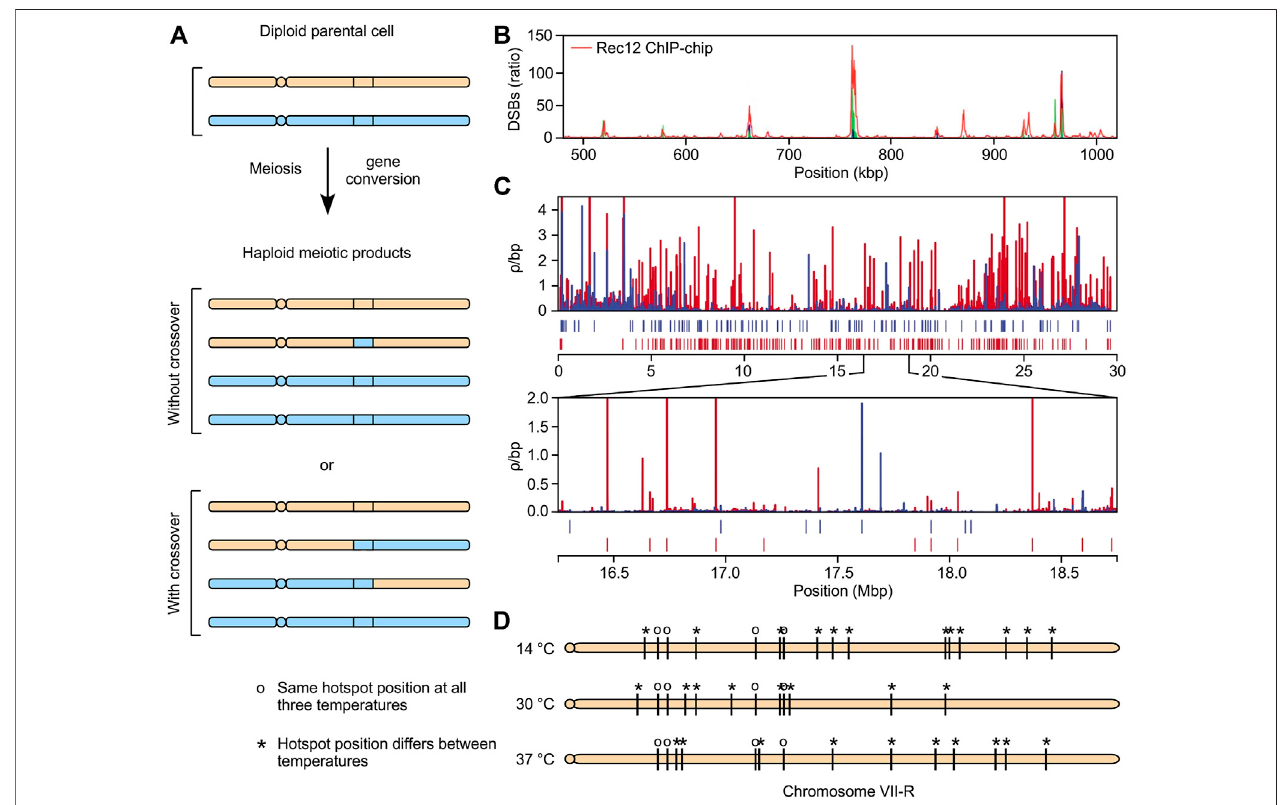
FIGURE 1 | Highly dynamic, extensive changes in the meiotic recombination landscape (A) Meiotic recombination leads to gene conversion, with or without reciprocalexchanges(crossovers) (B) Meioticallyinduced,recombination-initiatingdsDNAbreaks(DSBs)clusterathotspotsthatpositionrecombinationinthegenome. This example depicts frequency distribution of DSBs along a portion of chromosome one in fi ssion yeast (C) Example of evolutionarily rapid changes. Plot shows distribution of recombination rates along chromosome one in two different populations ( red, blue ) of stickleback fi sh, along with positions of identi fi ed hotspots ( tic marks ) (D) Example of environmentally induced changes. Plot shows effects of temperature on DSB hotspot positions ( tic marks ) on right arm of chromosome seven in buddingyeast.Wepositthatthedramatic,evolutionarilyrapid(panelC)andenvironmentallyinduced(panelD)changesintherecombinationlandscapeshareacommon molecular